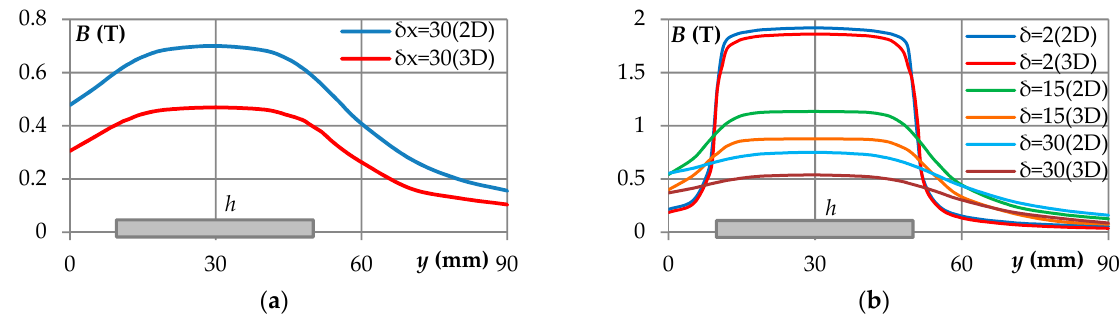
Figure 6. Dependence of reluctance torque τ ( a ) and flux density B on angular position of movable element α for working gap δ = 2, 15, 30 mm (for exciter shown in Figure 4) and ( b ) δ x = 30 mm (for exciter shown in Figure 5) .